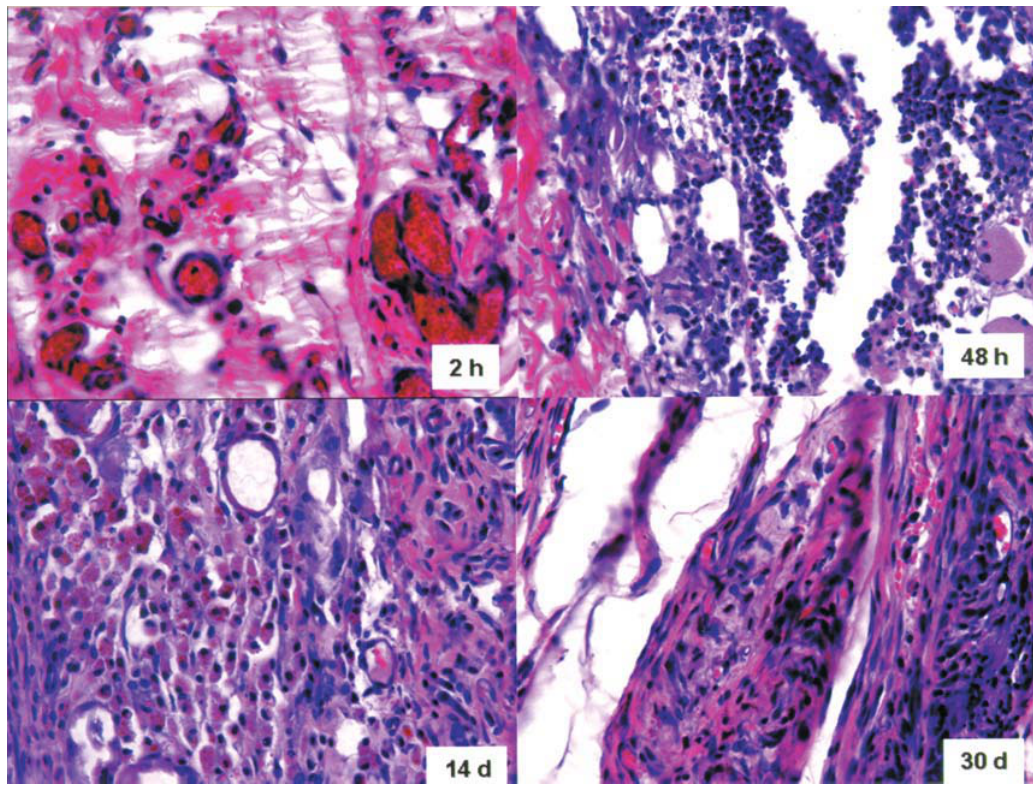
FIGURE 5 - Reaction of rat subcutaneous connective tissue to 2.0% Chlorhexidine solution (H.E.; x25)